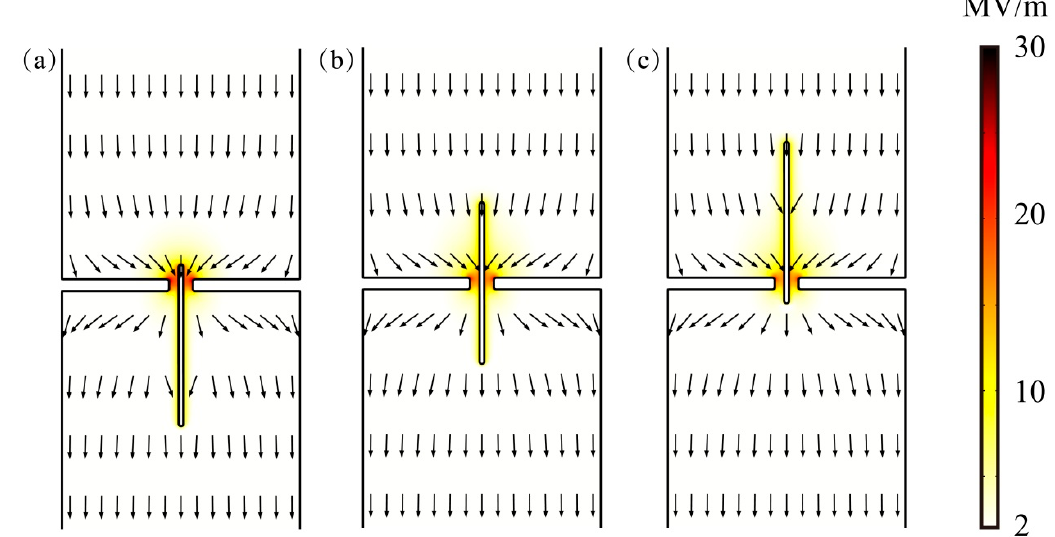
Figure 4. The electric field distribution around the nanopore for particle length L p = 200 bp and E = 2 MV / m when the particle center is located at ( a ) y p = − 75, ( b ) y p = 0, ( c ) y p = 75 bp. The darker colors in the diagram represent a stronger electric field, and the arrows indicate the direction of the electric field.